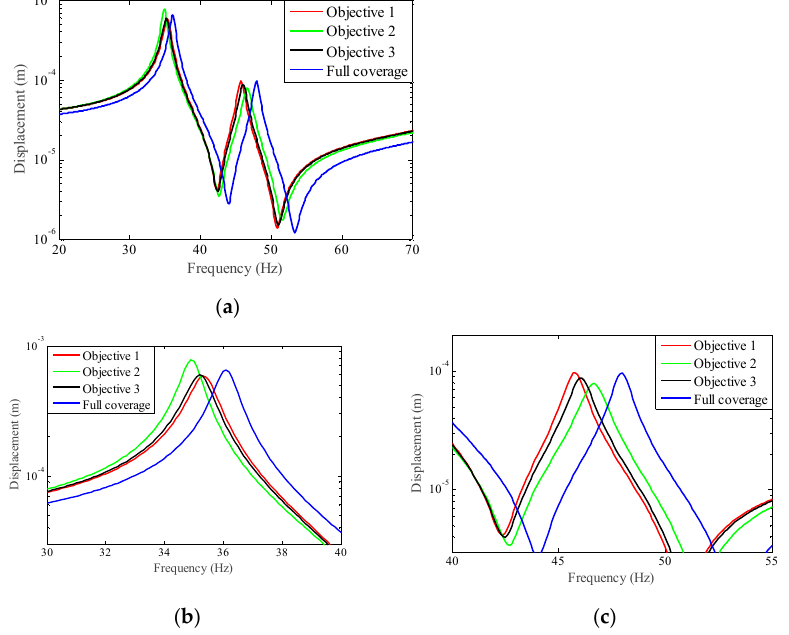
Figure 22. Comparison of the frequency response curves of full coverage structure and optimal designs: ( a ) The frequency response curves from 20 Hz to 70 Hz; ( b ) the detailed description in Mode 1; ( c ) the detailed description in Mode 2.